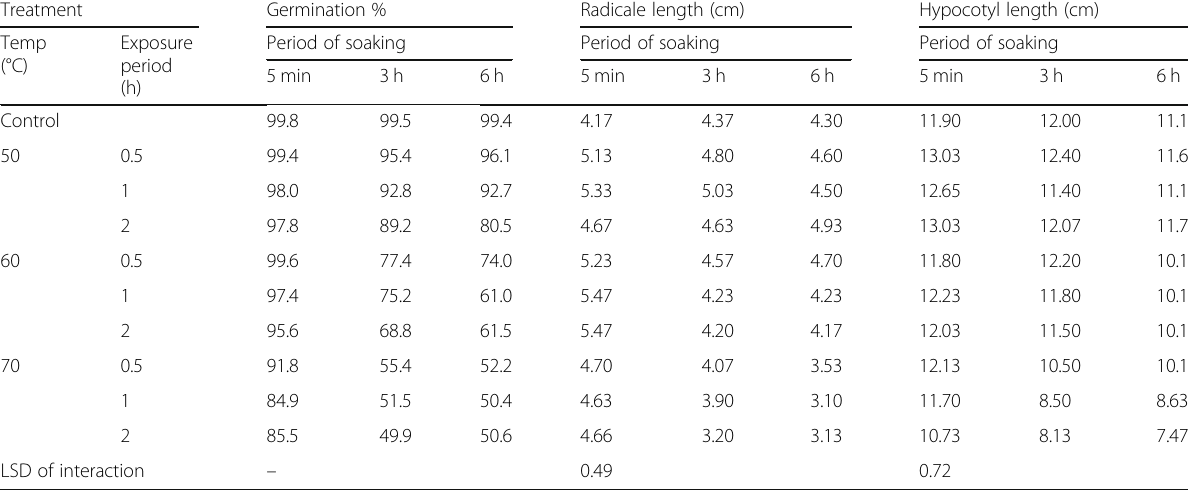
Table 2 Effect of seed hardening on germination percentage, radicale length (cm) and hypocotyl length (cm)